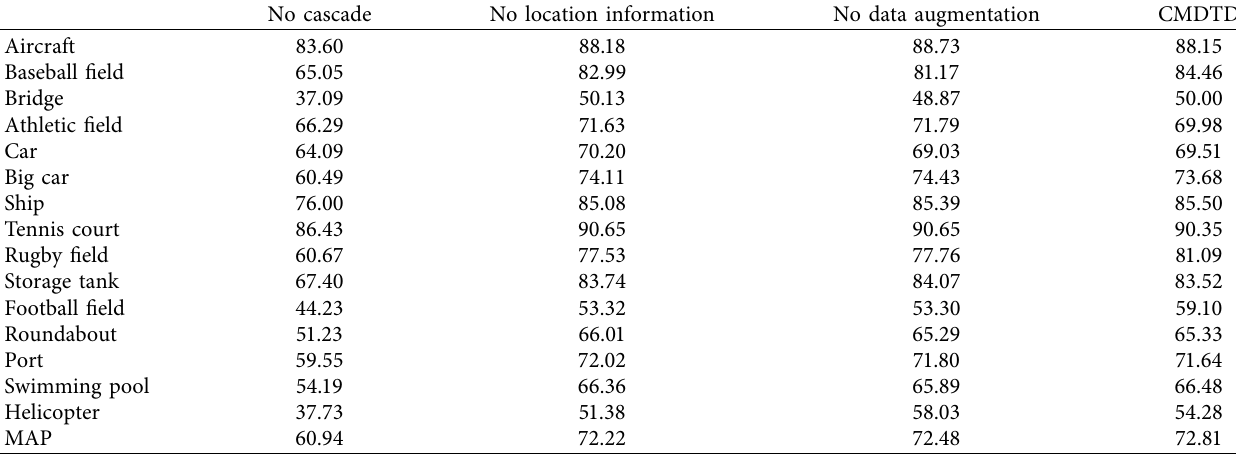
Table 6: Comparison results of different module settings (%).